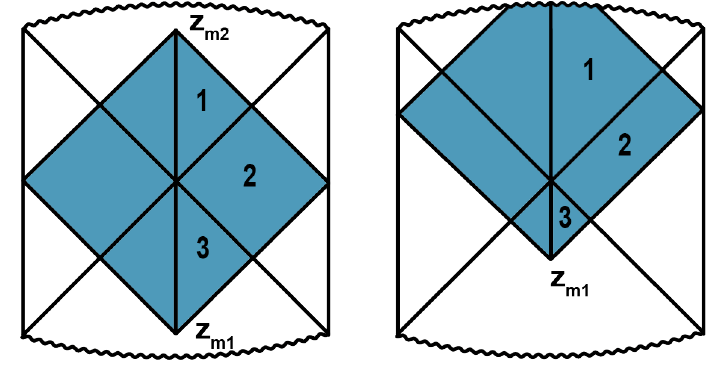
Figure 1 . WDW patch for a type D solution. Left: before t c . Right: after t c .